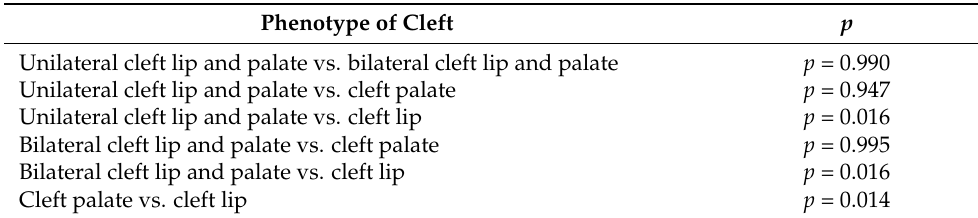
Table 4. Correlation between maternal BMI and cleft